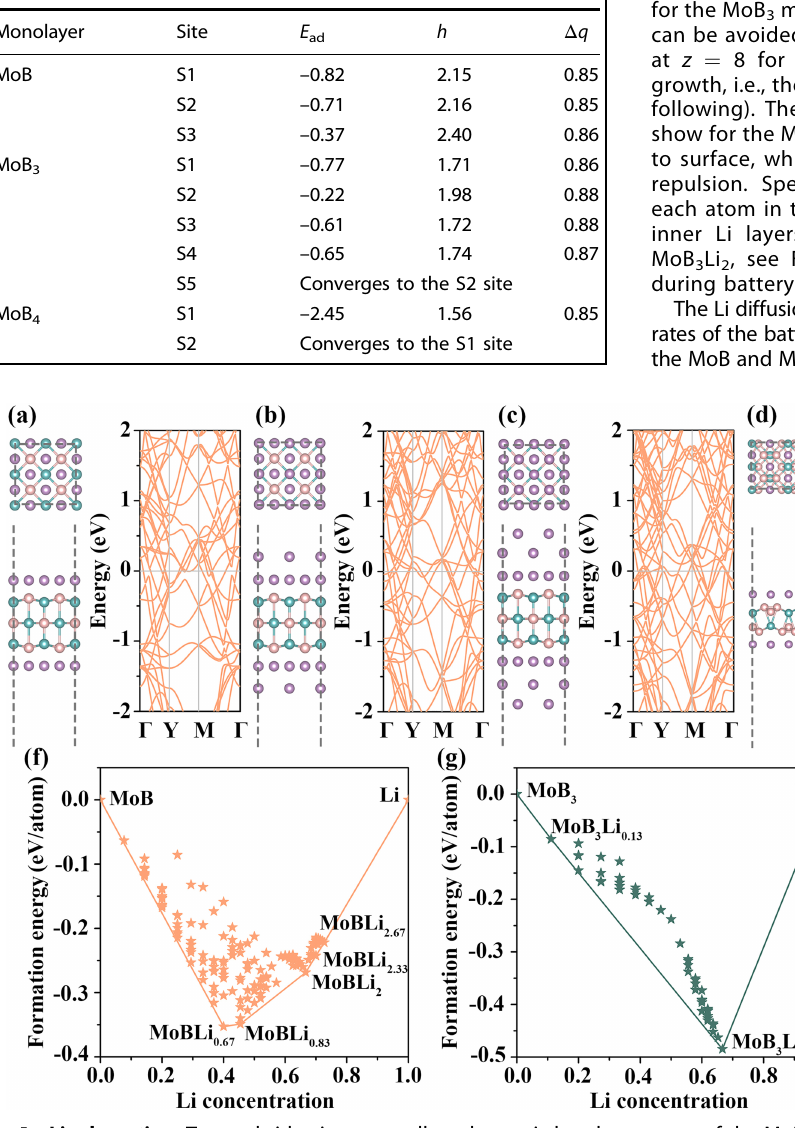
Table 3. Adsorption energies (eV), adsorption heights (Å), and charge transfers (electrons) of Li on the MoB x ( x = 1, 3, and 4) monolayers.